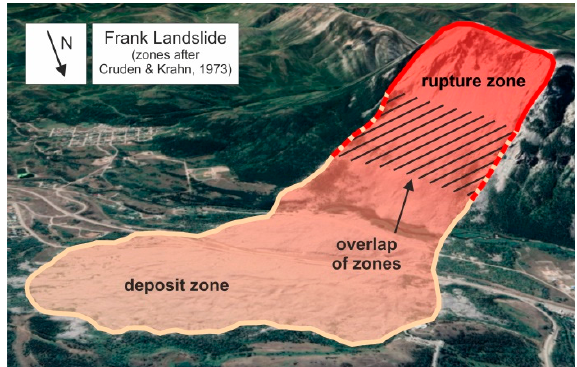
Figure 2. Difference between the entire landslide zone and the rupture zone exemplified by the Frank Landslide, Canada (No. 019.00 in Table A1 in the Appendix). Zones are drawn after Cruden and Krahn [29] (satellite imagery from Google Earth Pro [30]).